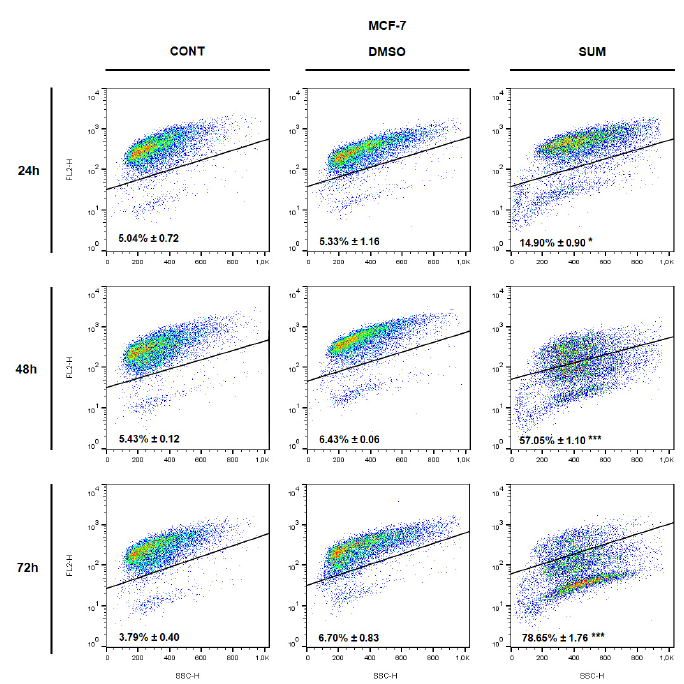
Figure 15. Mitochondrial membrane potential (MMP) changes in MCF-7 cells after SUM (155 µg/mL) treatment. Data were obtained from three independent experiments. Significant changes, control vs. SUM-treated cells * p < 0.05, *** p < 0.001.